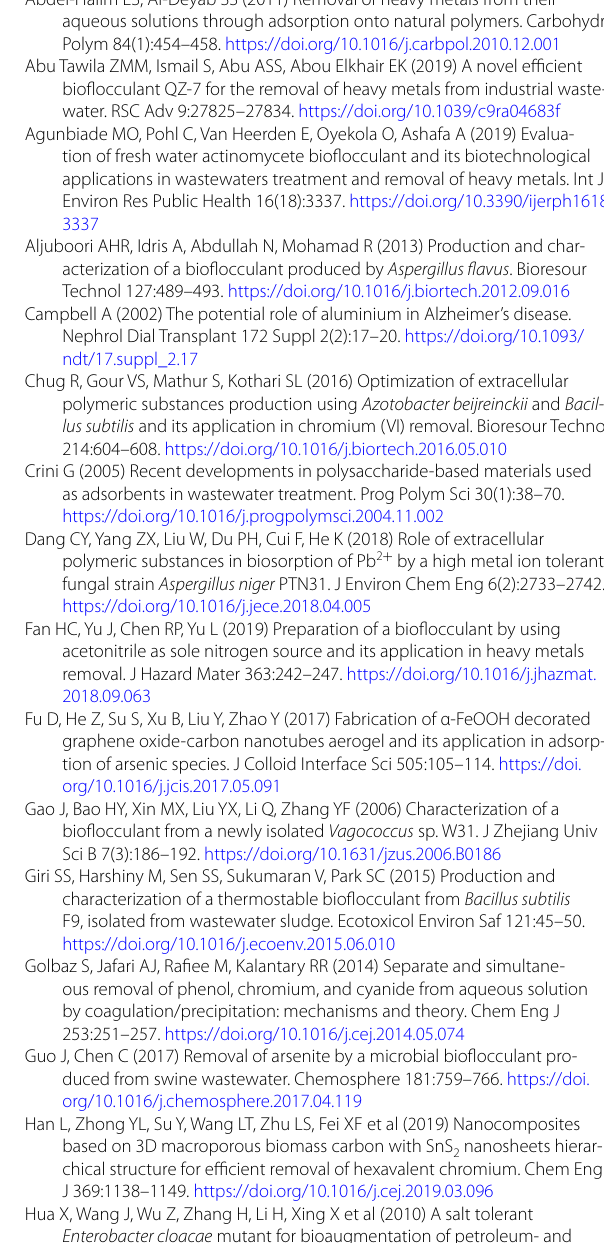
mutant T4-2. Figure S3. Showing the optimization of culture conditions for EPS production. Table S1. Showing the models and equations used for the adsorption Cr(VI) of by EPS of P. fluorescens mutant